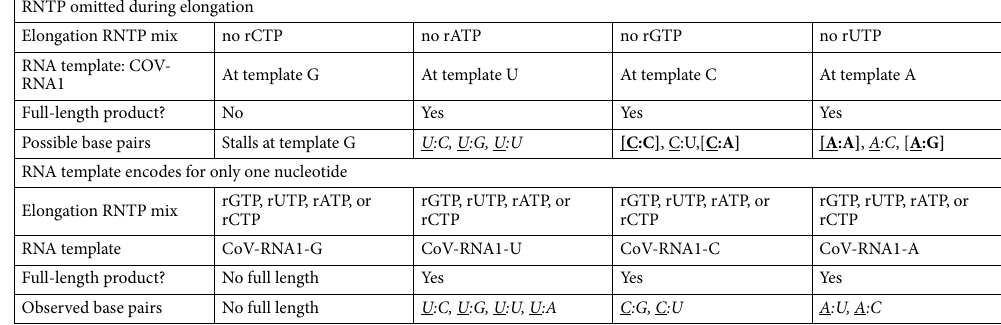
Table 2. Mismatch base pairs created by the RdRp. Bold bracket base pairs indicate mismatches that do not occur, and italic font indicates mismatches generated by the RdRp. Possible and observed base pairs are written in the 5 ′ –3 ′ direction, with the template nucleotide